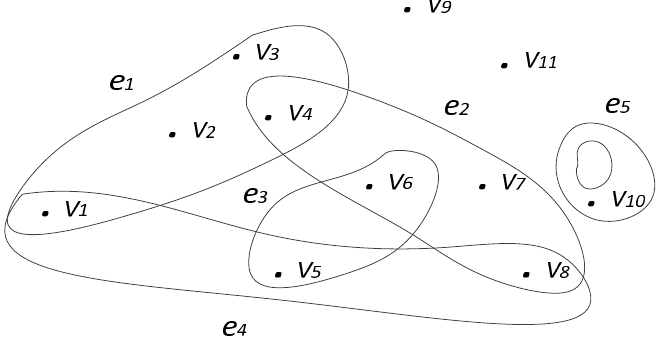
Figure 2. Example of a hypergraph.